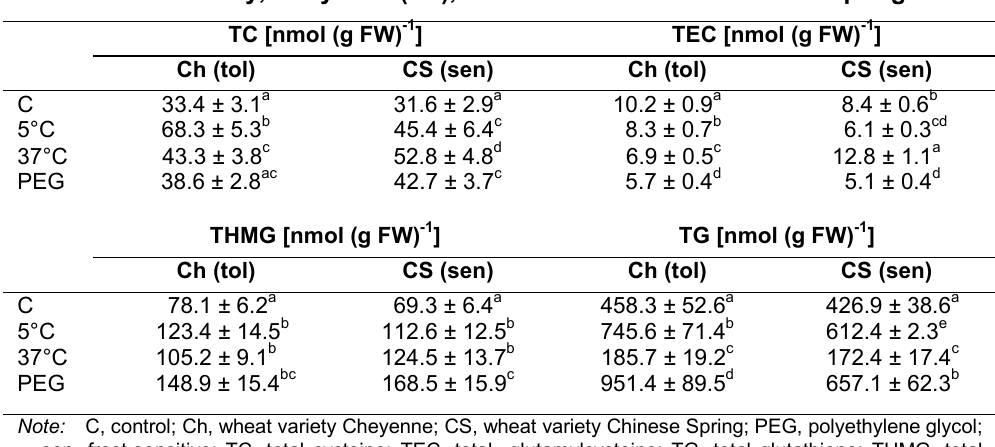
Effect of Abiotic Stresses on Total Cysteine, Total γγγγ -Glutamylcysteine, Total Hydroxymethylglutathione, and Total Glutathione Content in Shoots of a Frost-Tolerant Wheat Variety, Cheyenne (Ch), and a Frost-Sensitive Chinese